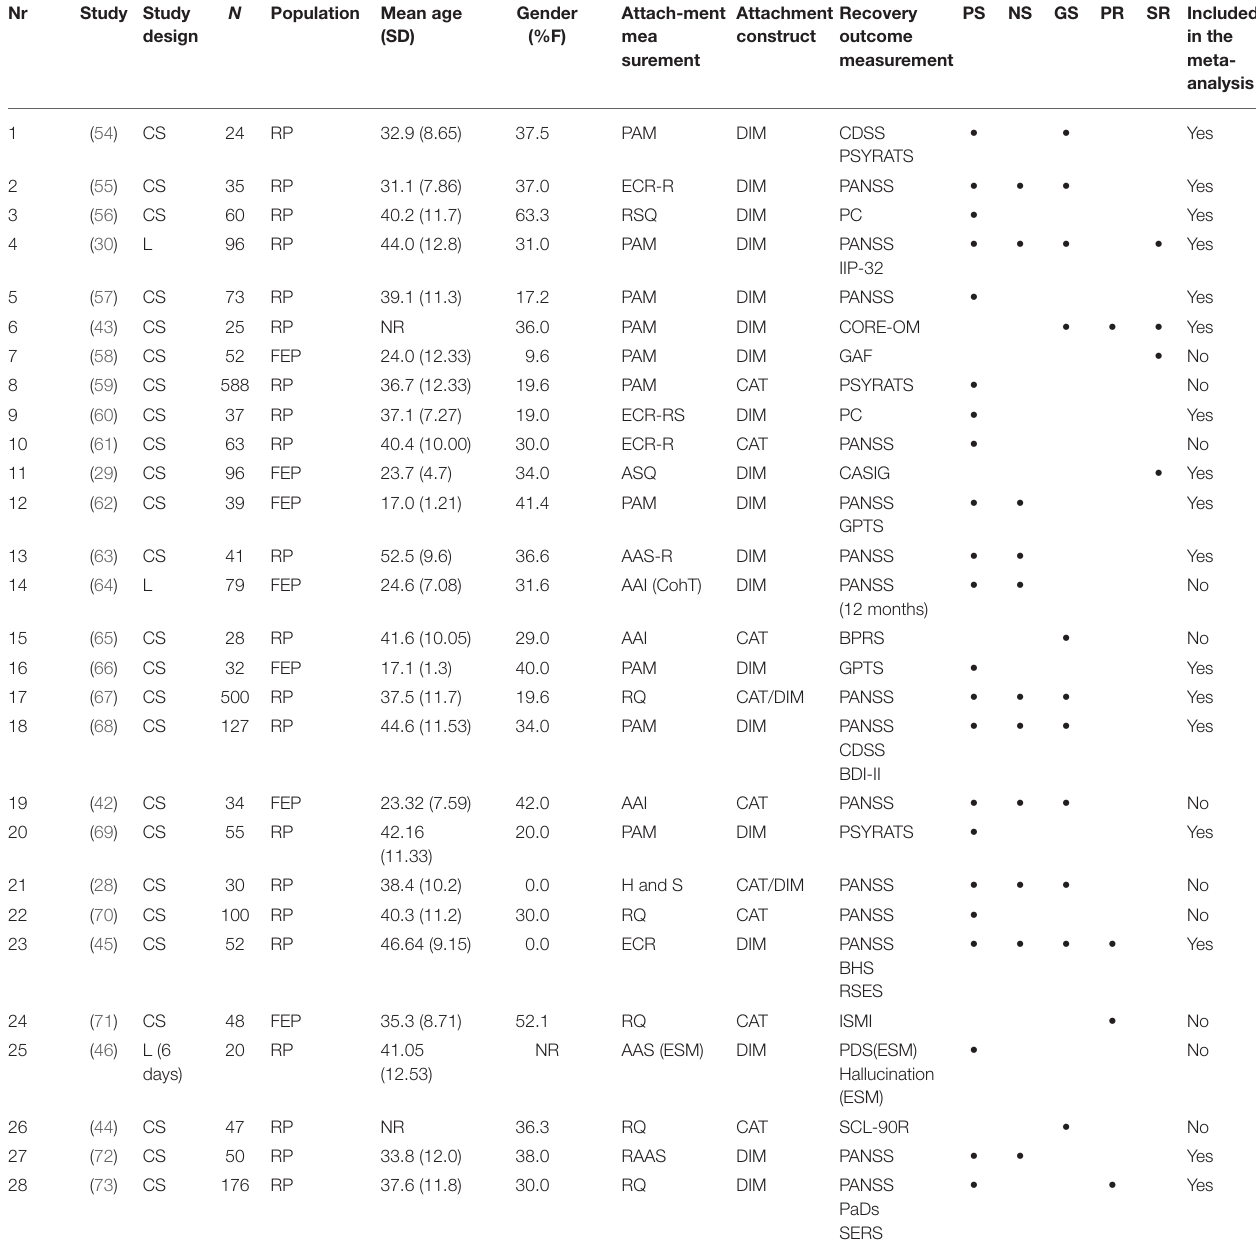
TABLE 2 | Overview of included